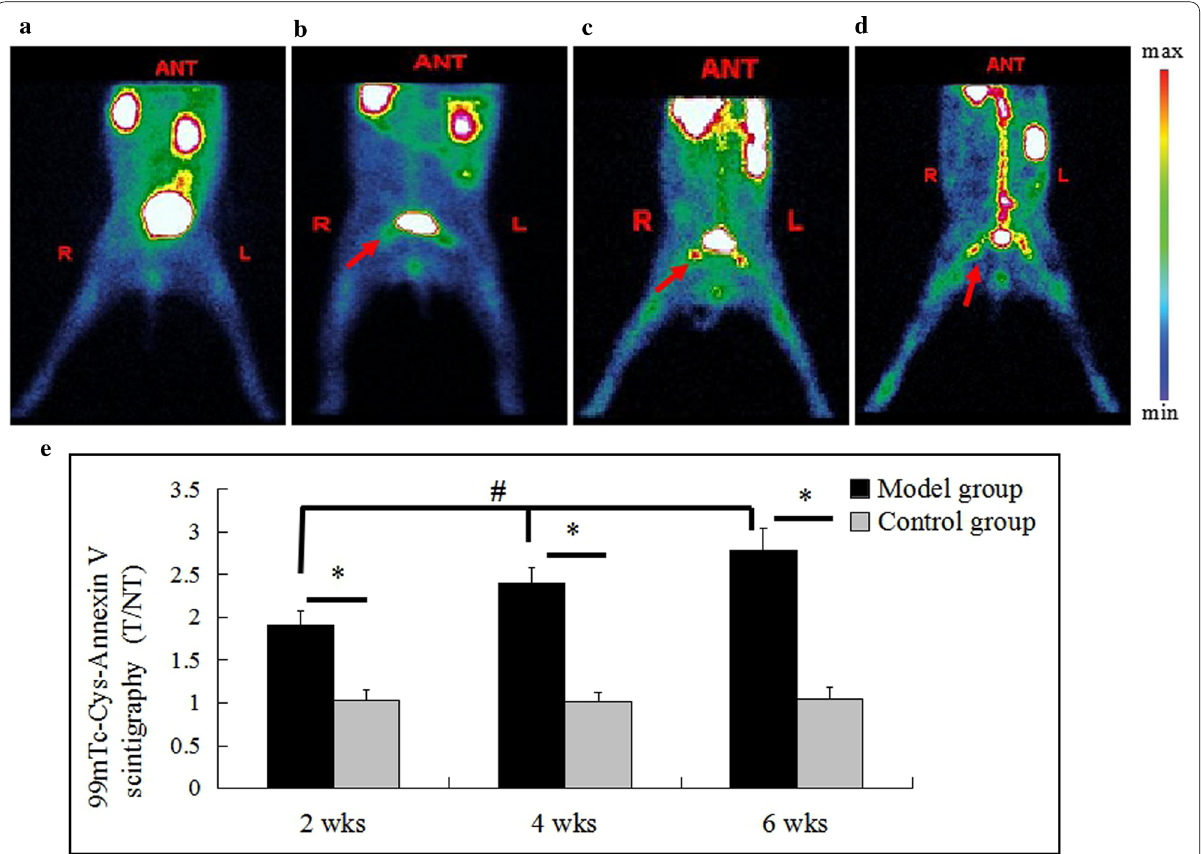
Fig. 2. 99m Tc-Cys-Annexin V SPECT imaging. a was the control group image; b , c , and d were the images at 2nd, 4th, and 6th week after the injection of the hormone in the model group.(Red arrows indicated abnormal radioactive concentration in the bilateral femoral heads). e : The T/NT ratio of the model group was significantly higher than that of the control group at each time point (* inter-group comparison, P < 0.05), and there was a statistically significant difference in the T/NT ratio within the model groups at each time point (# intra-group comparison, P < 0.05). Model group vs control group: the 2nd week (n 9 vs 8), 4th week(n 8 vs 8), and 6th week (n 9 vs = = =